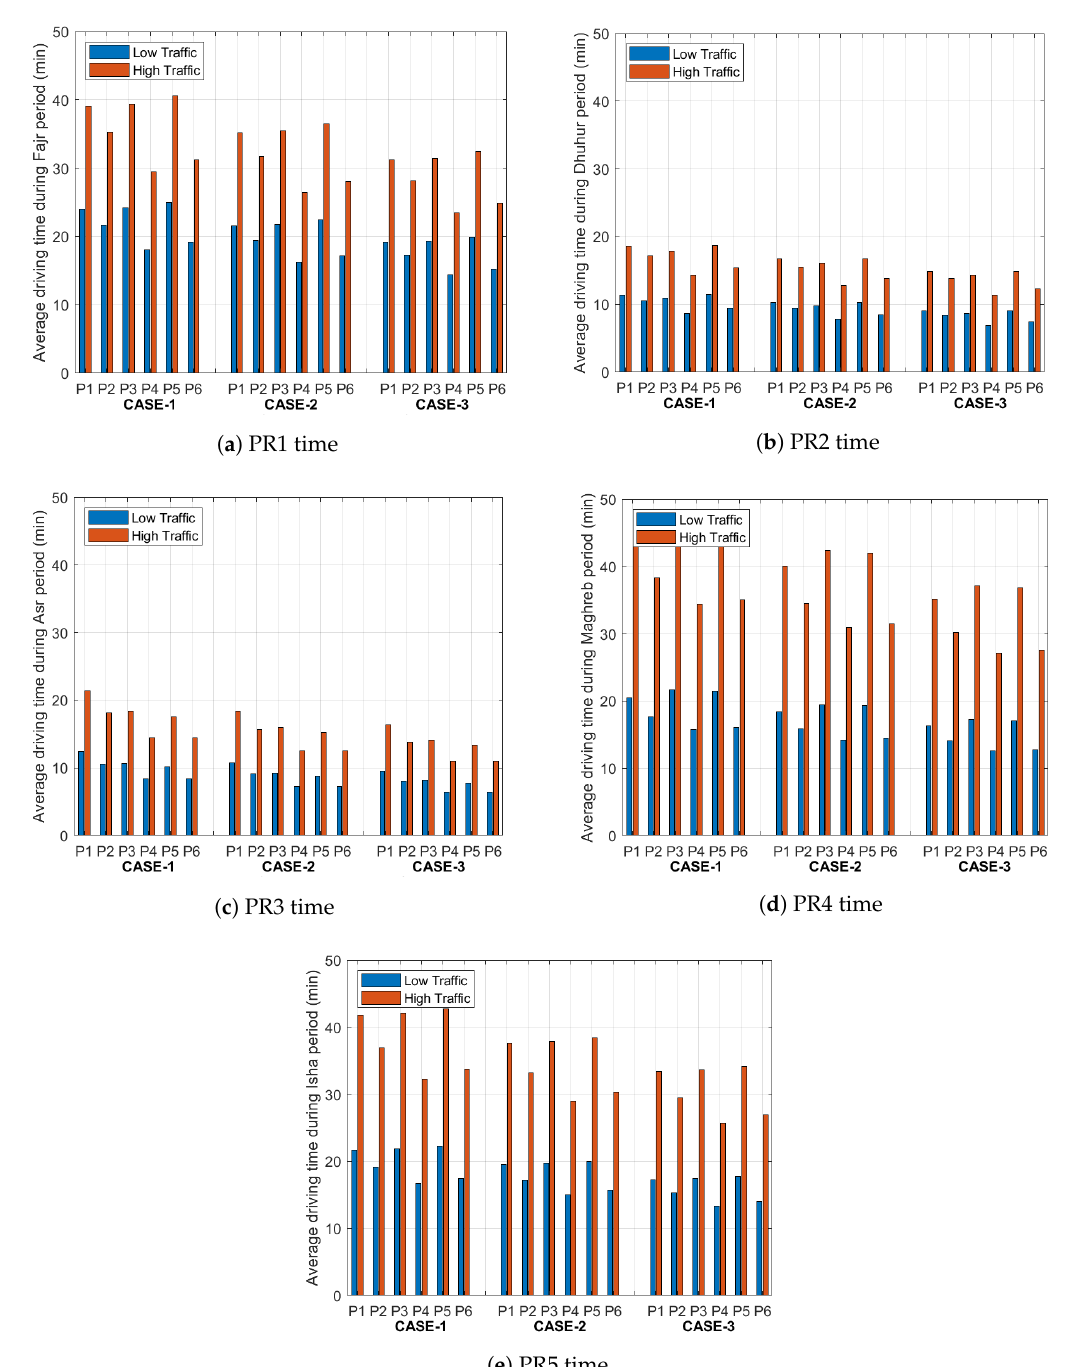
Figure 8. Average driving time (minutes) from the starting point to the six parking lots (P1, P2, P3, P4, P5 and P6) for the five time periods